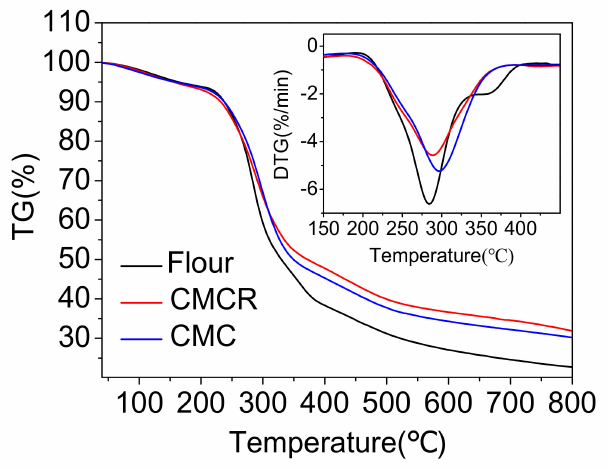
Figure 8. TGA analysis of cured resins filled with flour, CMCR and